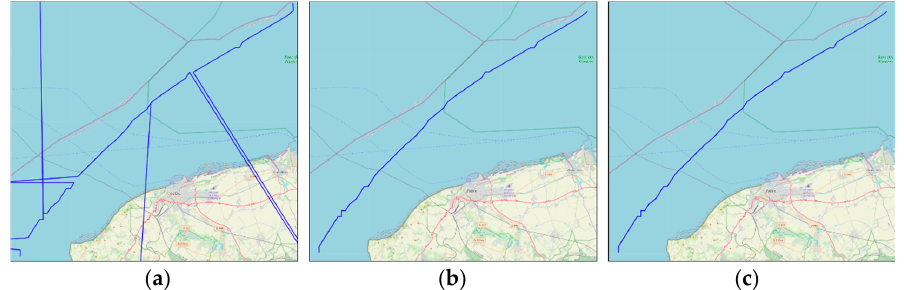
Figure 14. Comparison of denoising effects of MMSI 220002000. ( a ) Data preprocessing; ( b ) data cleaning; ( c ) trajectory